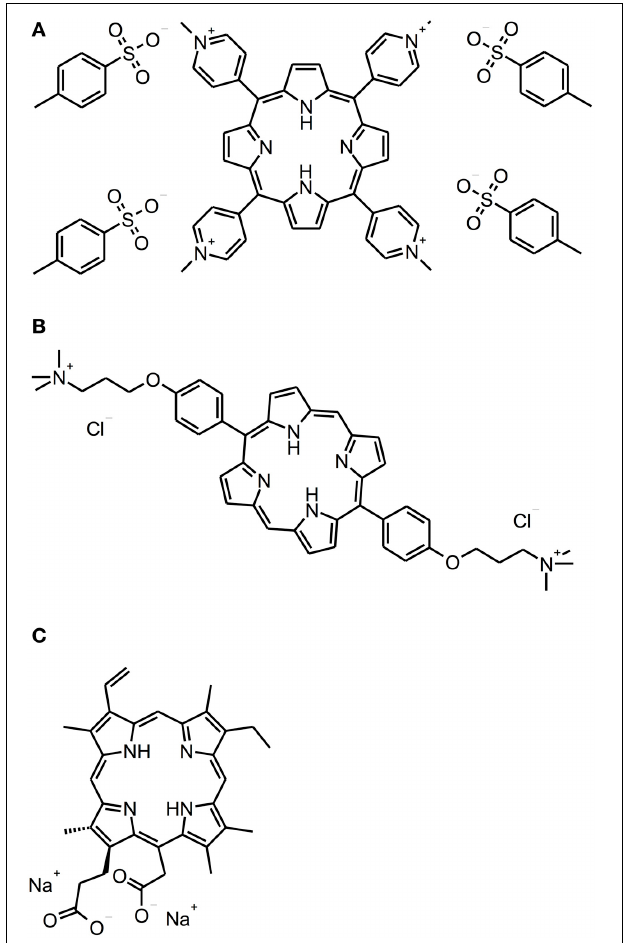
FIGURE 3 | Porphyrin and chlorin derivatives. Chemical structures of porphyrin and chlorin derivatives: (A) TMPyP. (B) XF-73. (C)